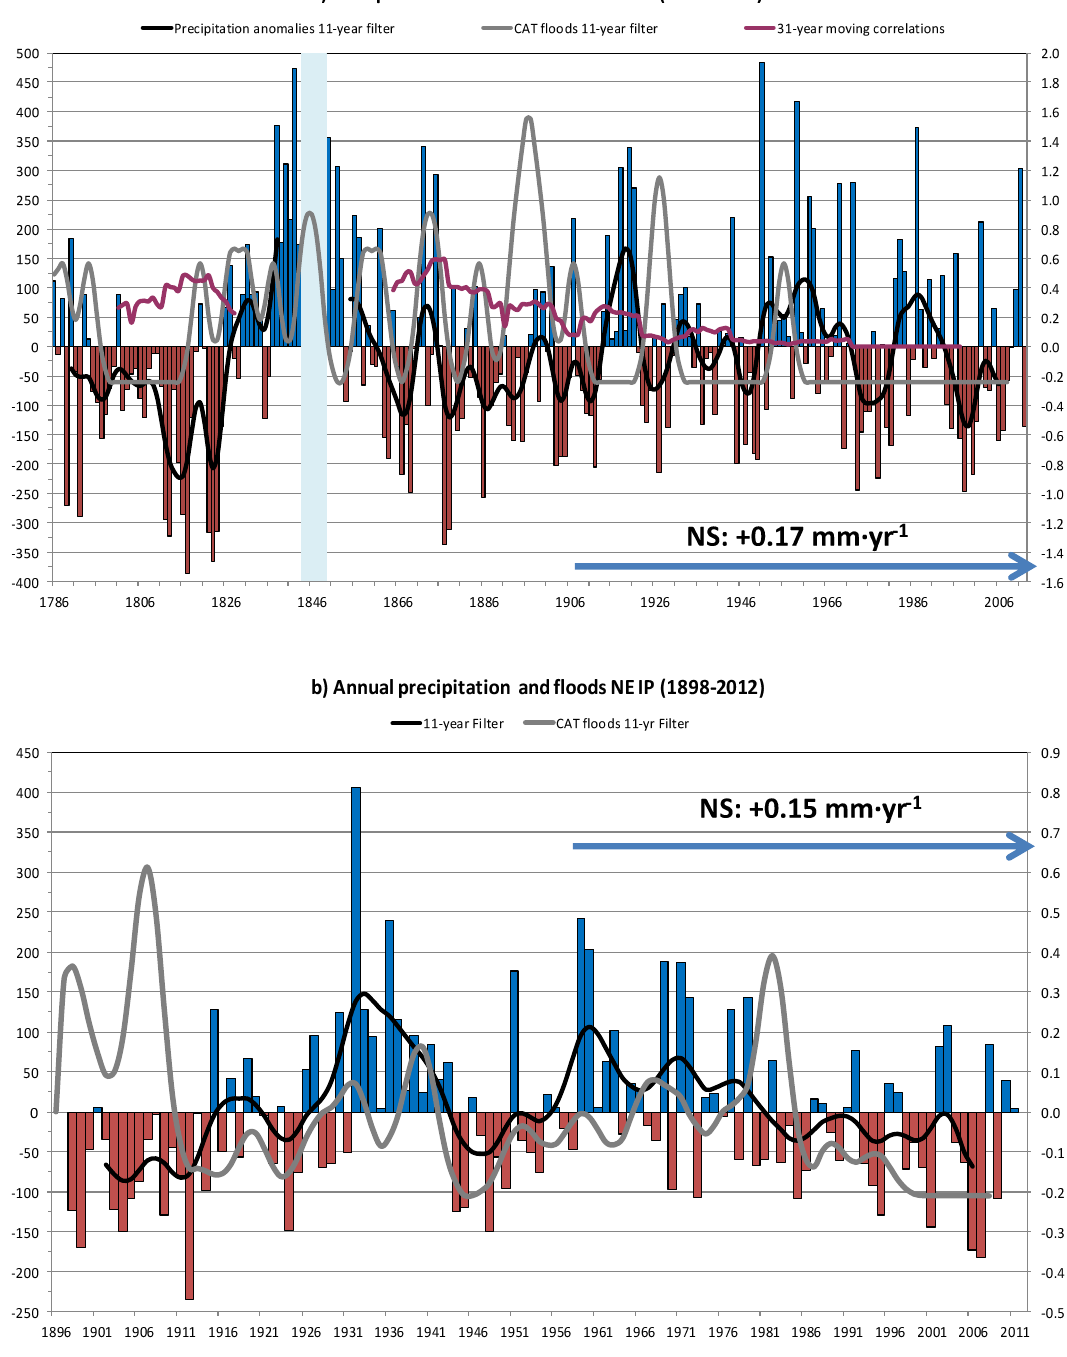
Figure 7. (a) Temporal evolution (1786–2012) of annual mean precipitation anomalies (coloured bars), catastrophic flood index series smoothed by an 11 year low-pass Gaussian filter (grey line) and the 31 year moving correlations between precipitation and catastrophic floods (pink line) for Barcelona. (b) Temporal evolution (1898–2012) of annual mean areal precipitation anomalies (coloured bars) for the north-eastern Iberian Peninsula (NEIP) and catastrophic flood index series smoothed by an 11 year low-pass Gaussian filter (grey line) for Catalonia. In both figures, black lines are the temporal evolution of annual mean precipitation anomalies smoothed by an 11 year low-pass Gaussian filter. The results of applying a trend analysis in the annual mean precipitation anomalies are also shown.